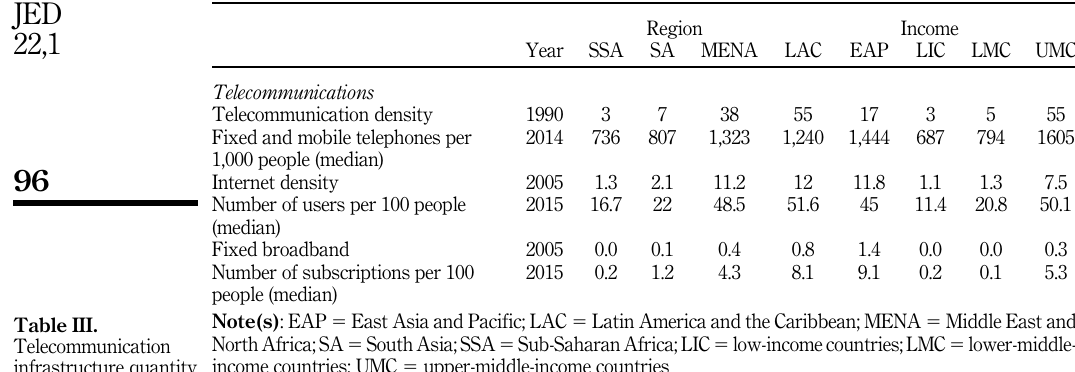
Table III. Telecommunication infrastructure quantity